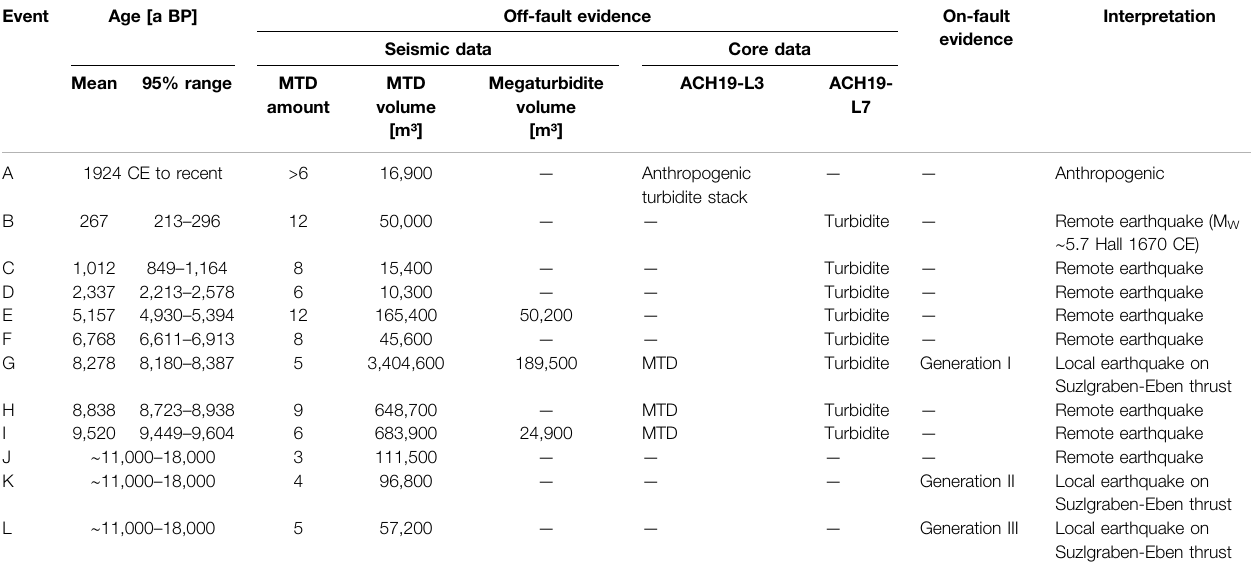
TABLE 3 | Event ages, paleoseismic evidence and